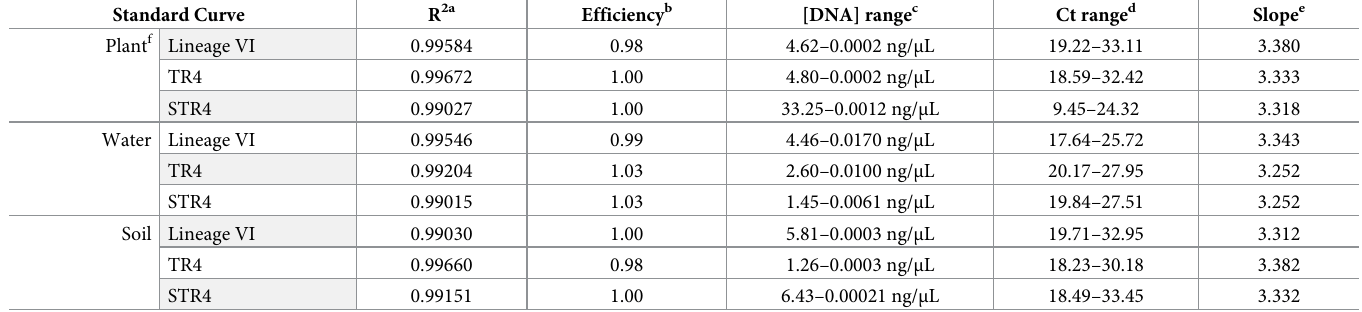
Table 3. Standard curve parameters for Fusarium oxysporum f. sp. cubense Lineage VI, TR4 and STR4 quantitative detection in plant, water and soil samples. Standard